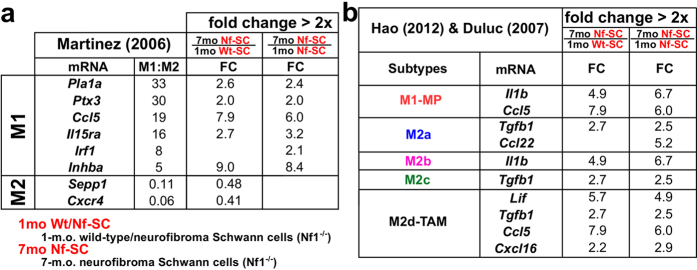
Differentially expressed M1-M2 signature genes in neurofibroma SCs.DEGs from 7-to-1 month comparison of SCs (a,b) were mapped to M1/M2 polarization signature genes collected from previous publications. Only differentially expressed signature genes are displayed.